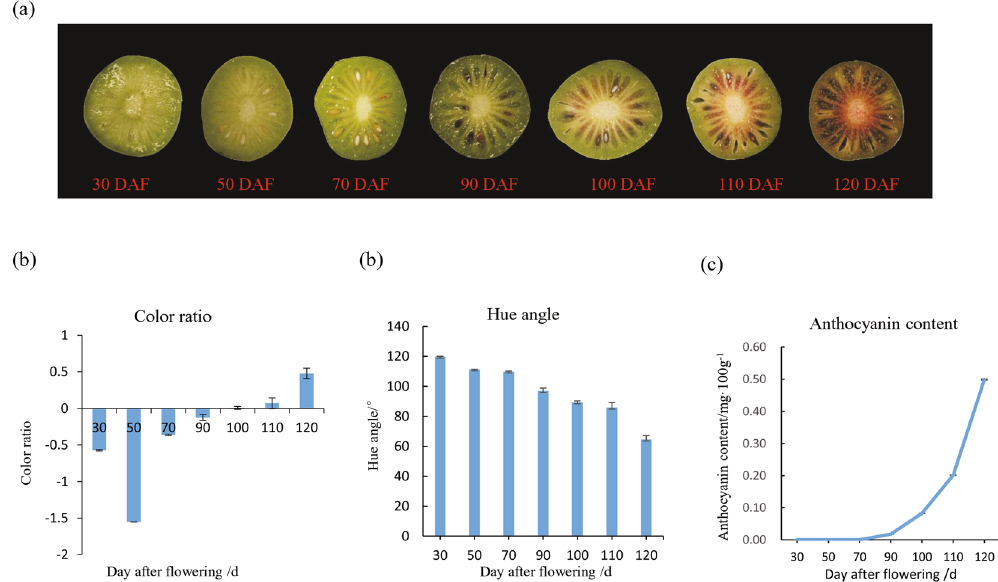
Figure 1. Developmental stages of A . arguta ‘Tianyuanhong’. ( a ) The changes in fruit color in ‘Tianyuanhong’ during fruit development. ( b ) Changes in the color ratio of ‘Tianyuanhong’ during fruit development. ( c ) Changes in the hue angle of ‘Tianyuanhong’ during fruit development. ( d ) The anthocyanin content in ‘Tianyuanhong’ during fruit